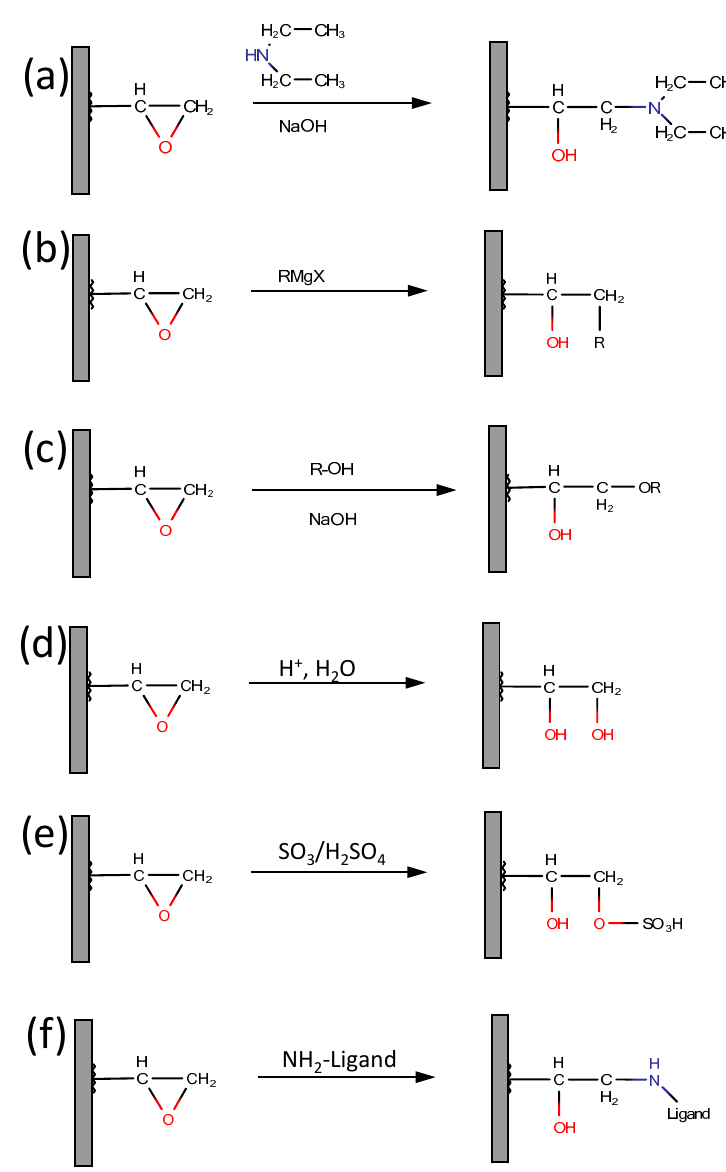
Figure 5. Examples of chemical routes to functional groups on polymer monolith surface using the epoxy group as the starting point, ( a ) functionalization with diethyl amine ethyl; ( b ) Alkyl addition via Grignard reaction; ( c ) alkylation; ( d ) hydrolysis; ( e ) sulfonation; ( f ) biofuctionalization, adapted and redrawn from [9].